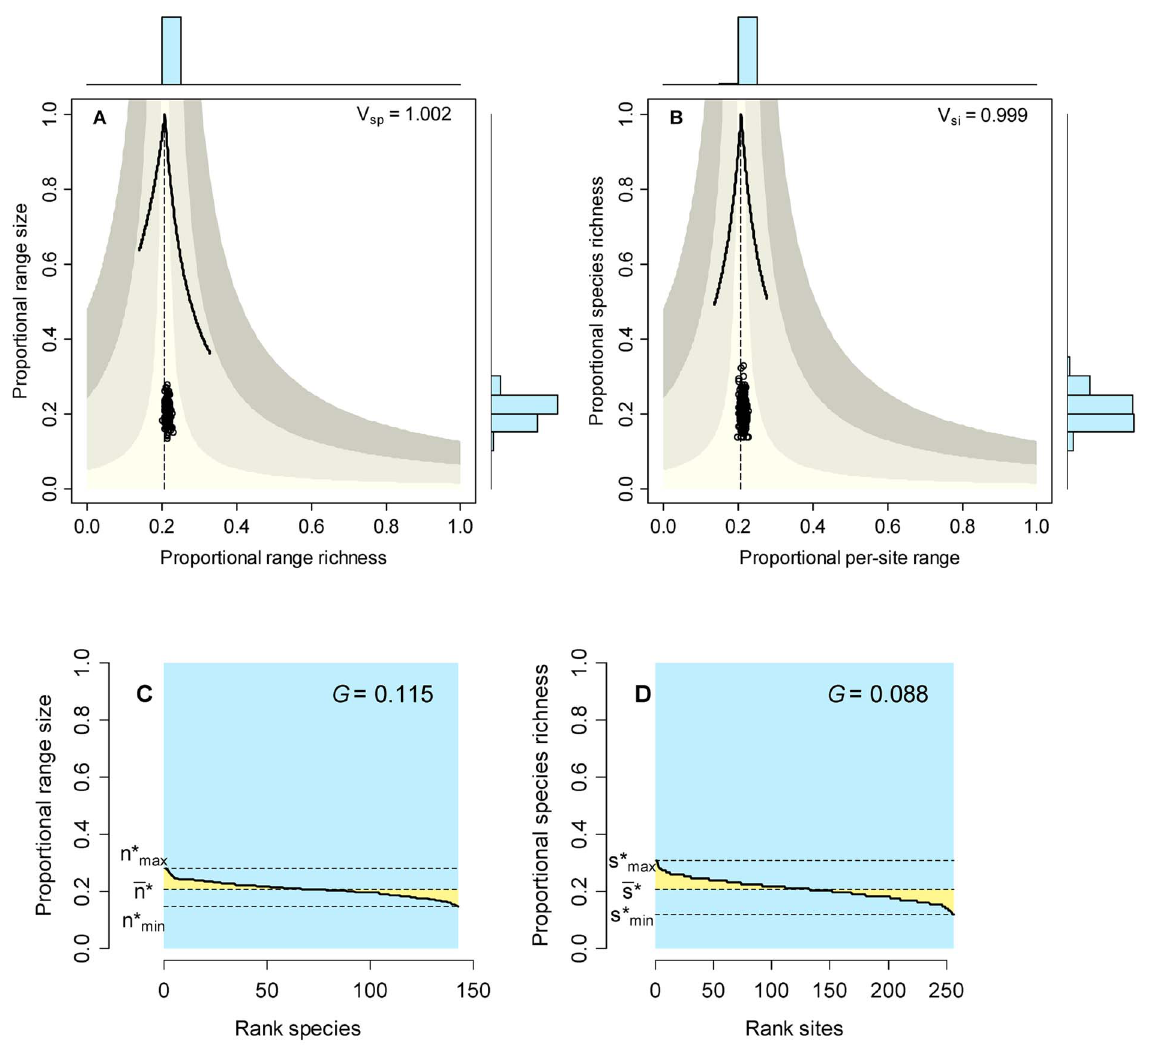
Figure 2. Initial conditions of the neutral models described in the text. Range diversity plots by species (A) and by sites (B) show the values of Schluter’s variance ratio index. Vertical dashed lines correspond to the value of f (cid:2) ~ (cid:2) nn (cid:2) ~ (cid:2) ss (cid:2) ; solid curves show maximum possible values in richness and range size, and shaded areas show the average covariance of species and of sites (from the vertical line outward, limits are covariance + / 2 0.01, 0.05, 0.1. Rank plots depict the range-size (C) and species richness (B) frequency distributions and the value of Pearson’s measure of skewness; colors as in Figure 1.